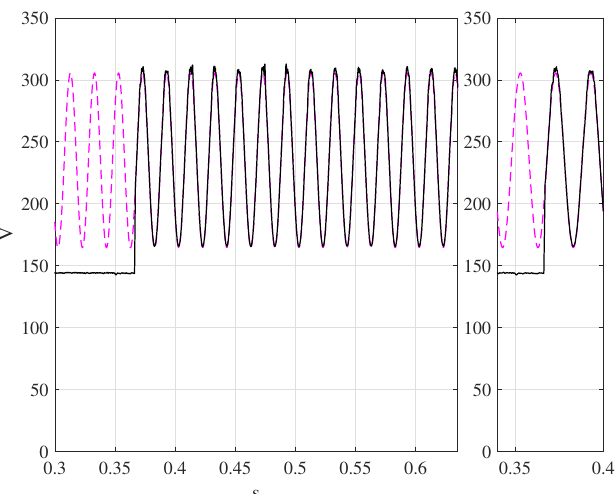
Figure 7. Output tracking of the capacitor voltage with α = 314 (50 Hz). Reference signal in dashed line, and capacitor voltage in solid